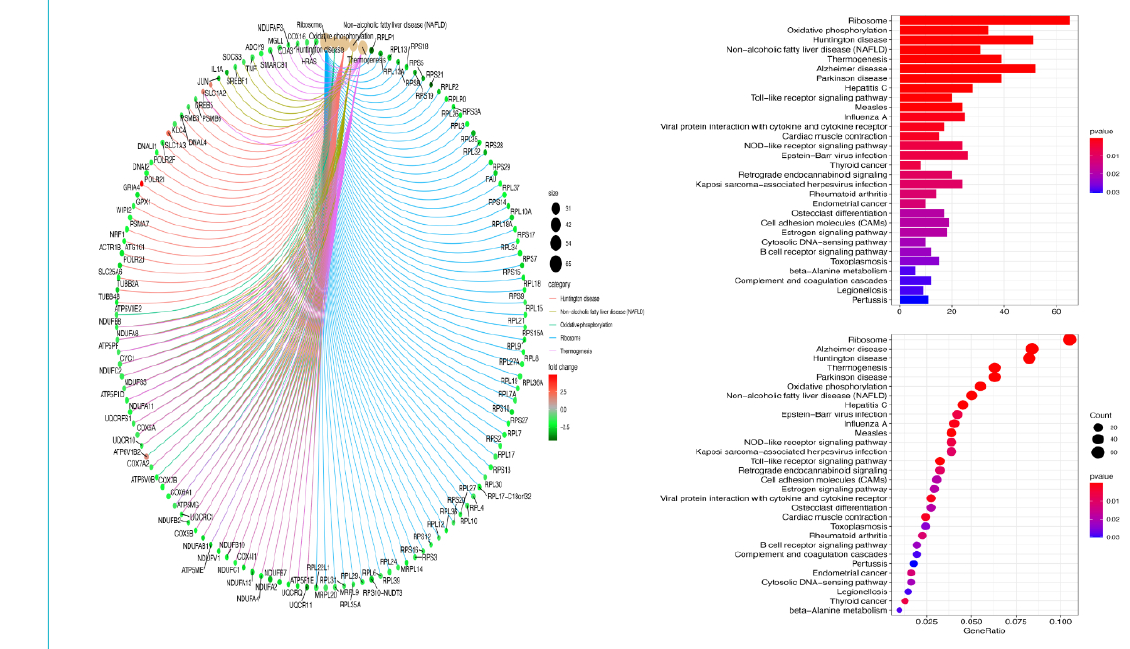
Figure 5: Top five enrichment results of the canonical pathway analysis of the DEGs in the yellow and grey modules. Abbreviations: DEG, dif- ferentially expressed